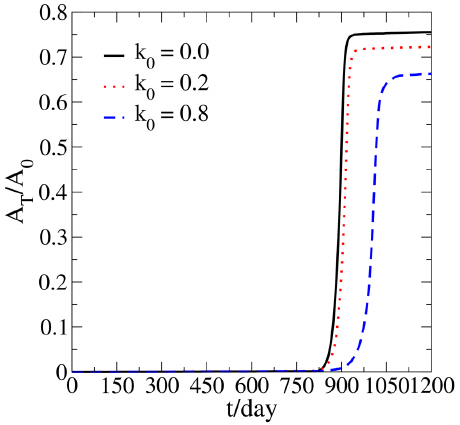
Figure 6. Tumor area A T normalized by the area A 0 of the growth permitting region of a simulated noninvasive tumor growing in the ECM under different killing rates by microen- vironmental suppression factors. The parameter k 0 is the fraction that the suppression factors from the microenvironment kill the actively dividing proliferative cells when the suppression factors counteract these cells.